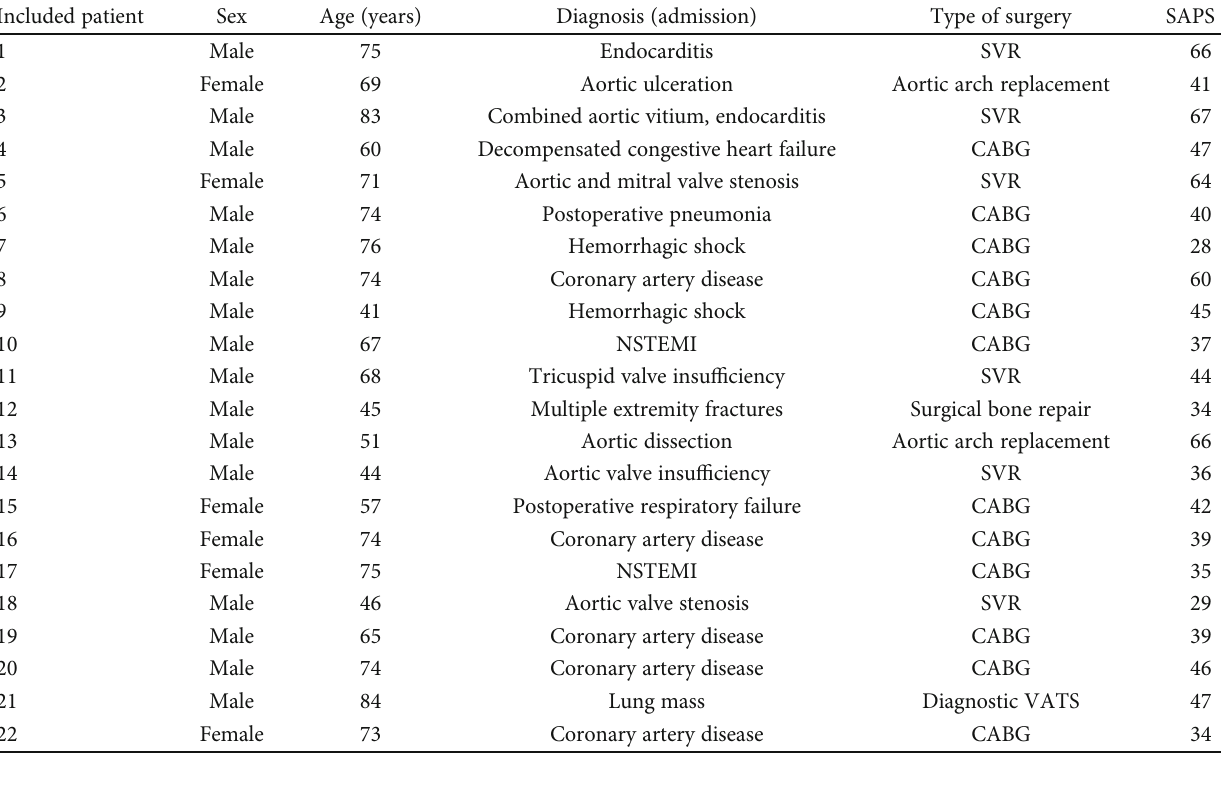
Table 2: Respiratory characteristics displayed as mean and standard deviation.